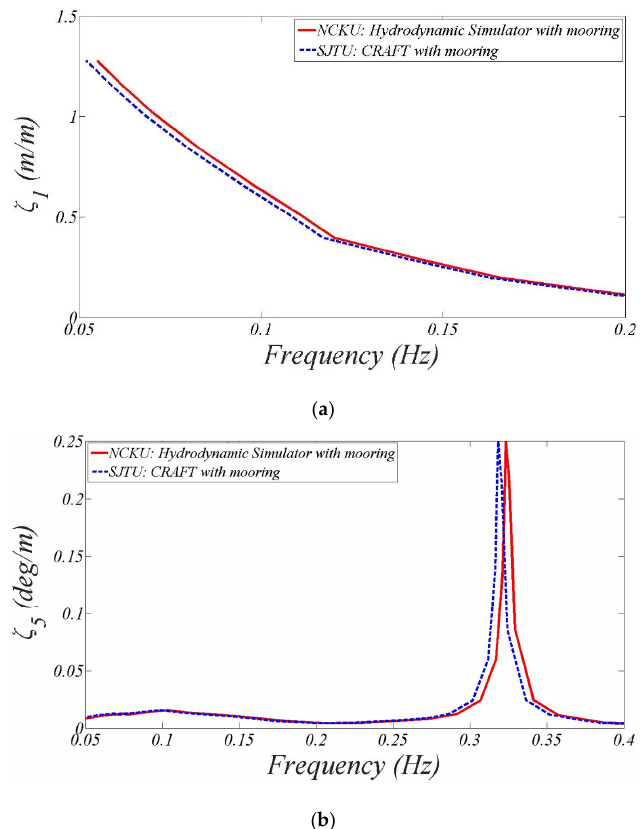
Figure 21. The performance of ( a ) surge, and ( b ) pitch RAOs as a function of wave frequency for the UMaine TLP by comparing hydrodynamic simulator with FAST.